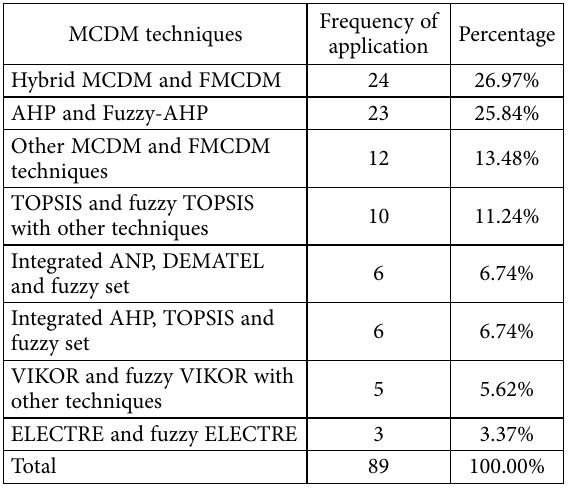
Table 3. Summary of applications of the MCDM techniques